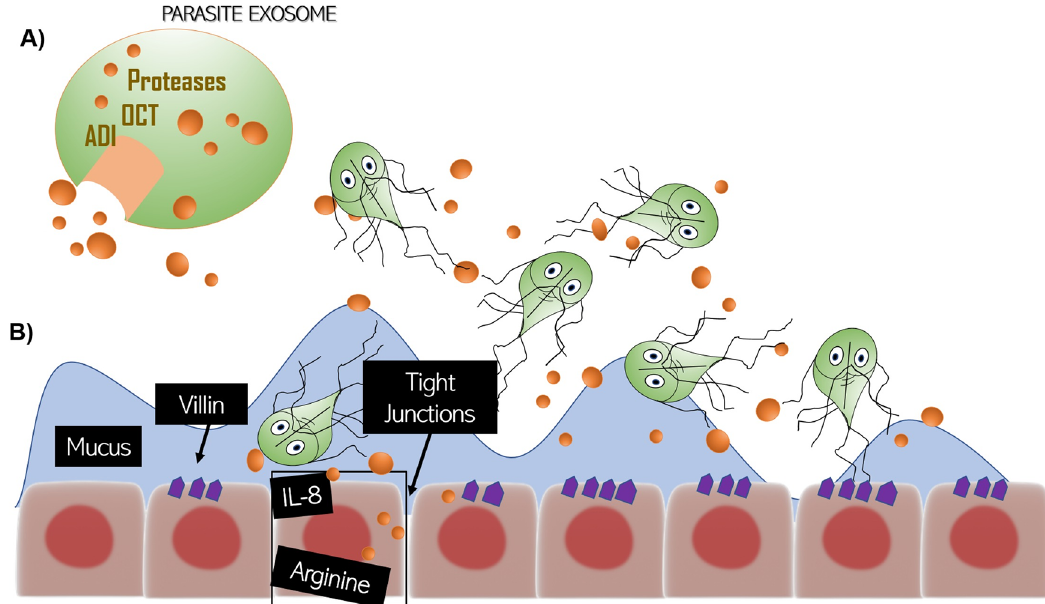
Fig 1. Interaction of Giardia and the host. (A) Parasites release proteins, like secreted proteins and proteins contained in macrovesicles and microvesicles, such as ADI, OCT, and several proteases. (B) These secreted factors can degrade tight junction proteins and villin in the epithelial cells, degrade mucins and cytokines secreted by cells, and metabolize arginine resulting in immune evasion and immunomodulation. ADI, arginine deiminase; OCT, ornithine